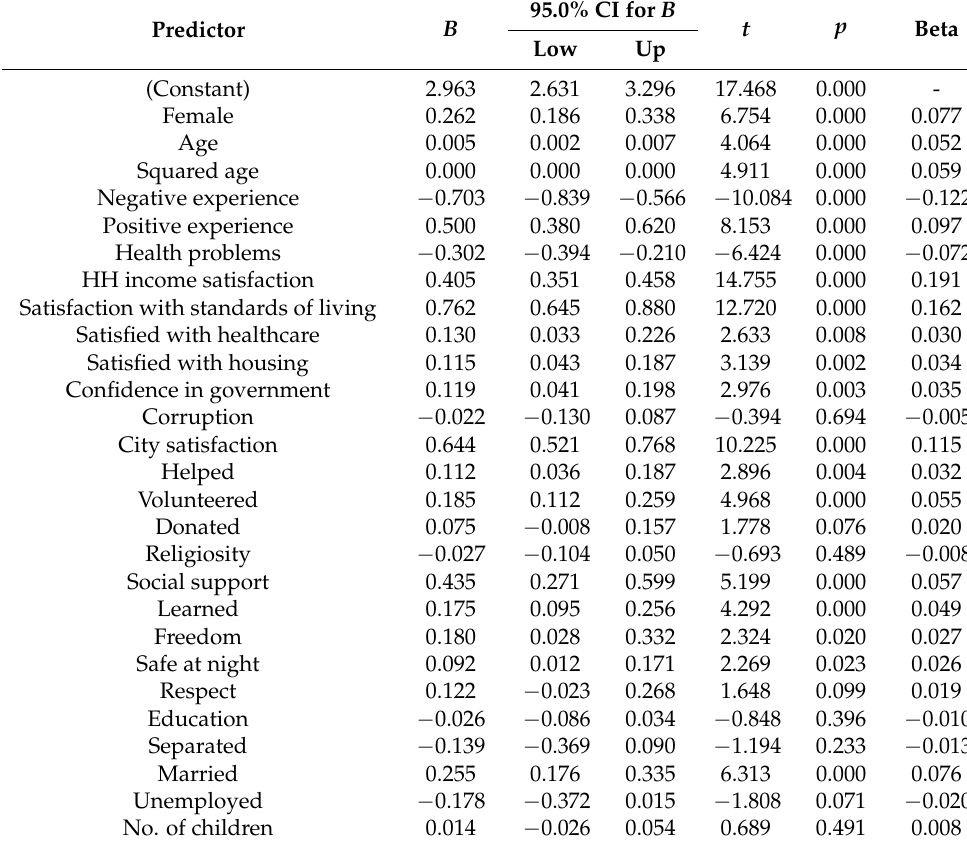
Table 2. Comprehensive Regression